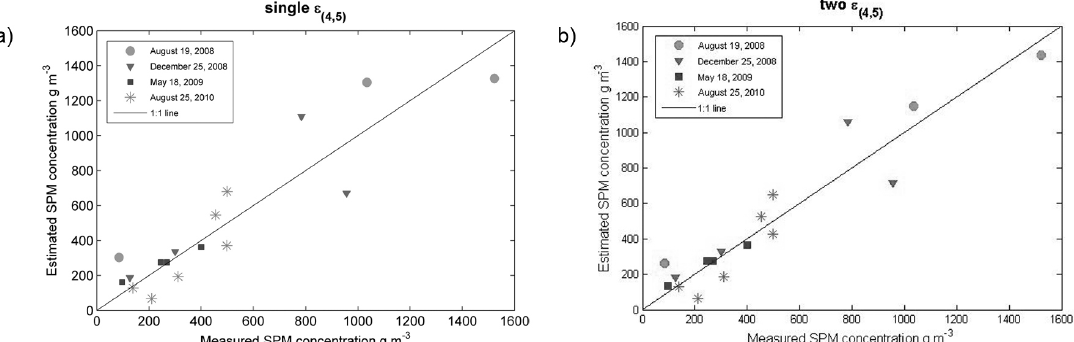
Fig. 3 (a) Measured versus estimated SPM concentration on four days using a single mean value of ε (4,5) ; (b) measured versus estimated SPM concentration on four days using two mean value of ε (4,5)